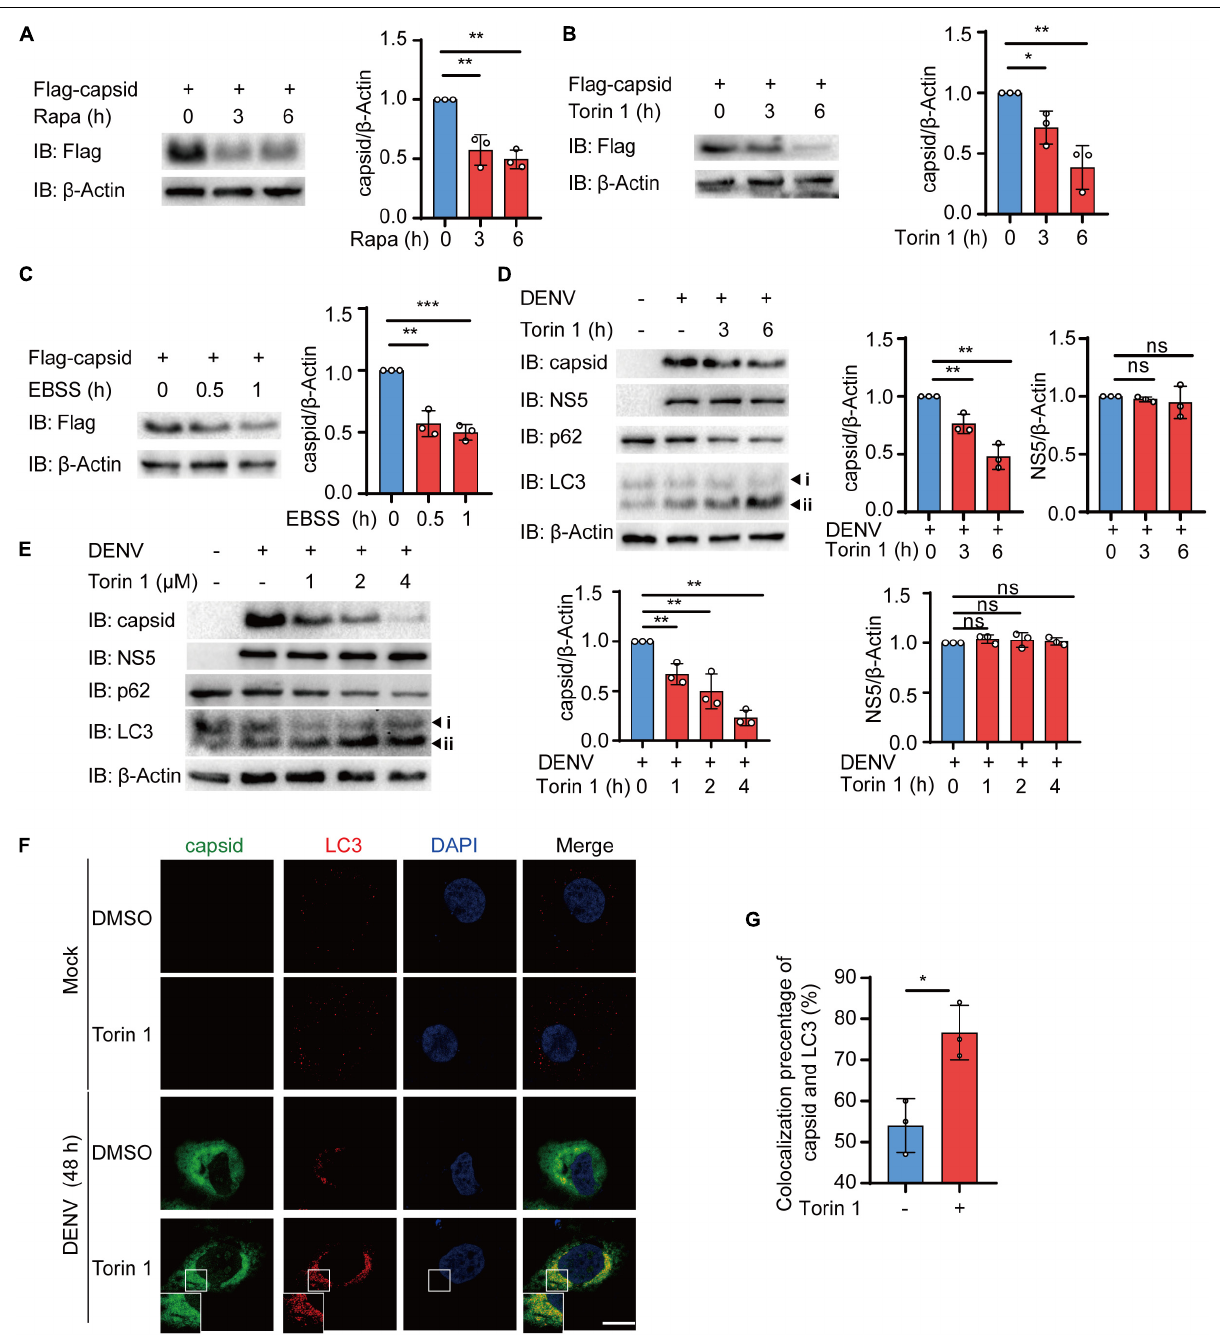
Frontiers in Microbiology |